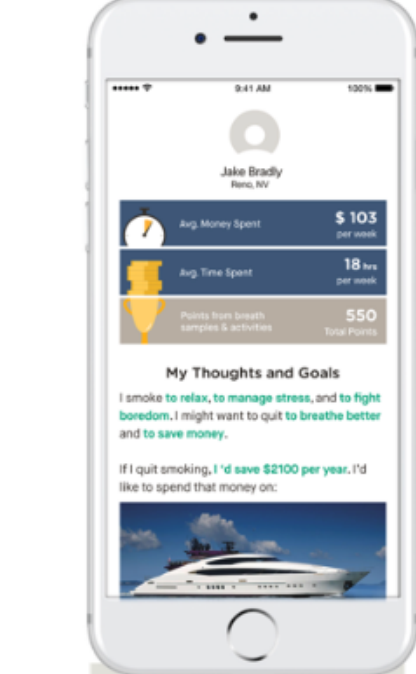
Figure 3. Example Pivot